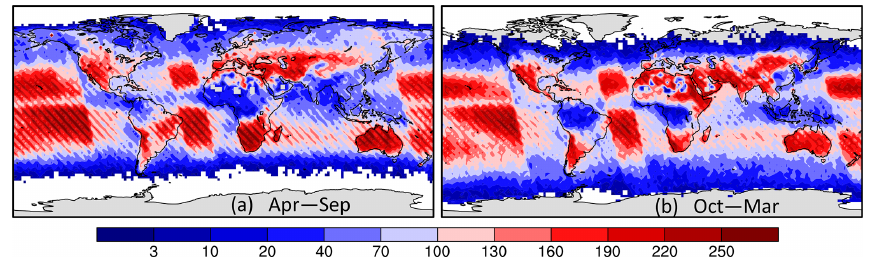
Figure 4. The number of 10s average spans with good data falling within each 2 ◦ × 2 ◦ bin across September 2014–October 2020 for (a) April–September and (b) October–March.